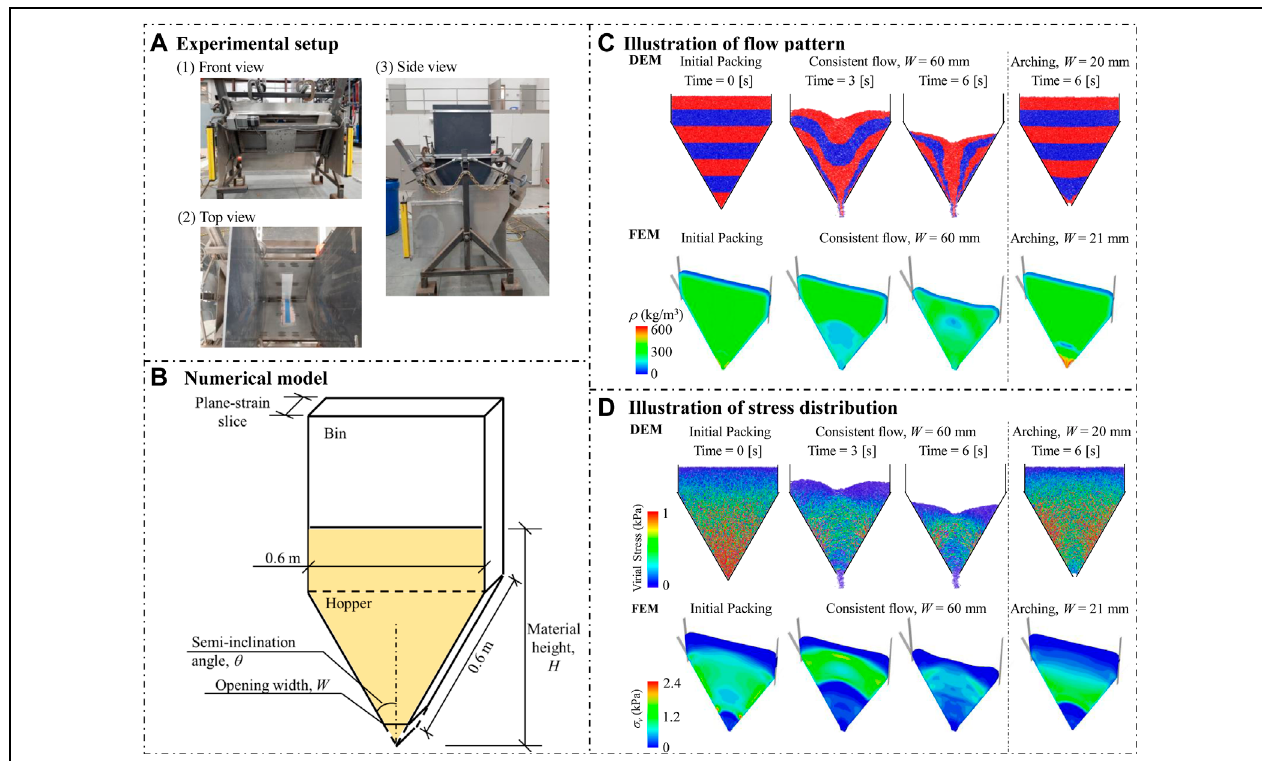
FIGURE 1 | Overview of the hopper flow problem: (A) The top, side and front views of the customized hopper; (B) The geometry of the numerical models with simplified hopper thickness; (C) The comparison of flow pattern and arching from the DEM and FEM models; (D) The comparison of the stress distributions for the consistent flow and arching cases from the DEM and FEM